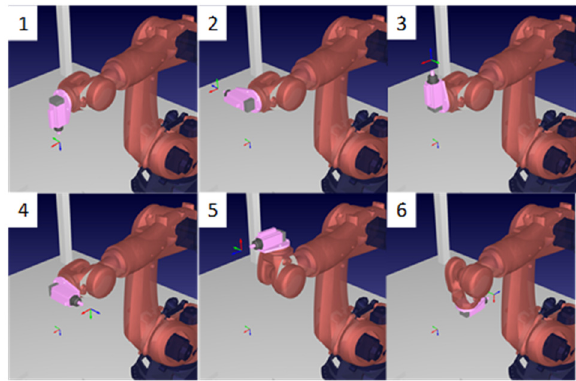
Figure 4. (1 – 4 ) Rotation about A6 axis to establish A6 rotation center; ( 5 – 6 ) rotation about A5 axis to establish A5 rotation center.